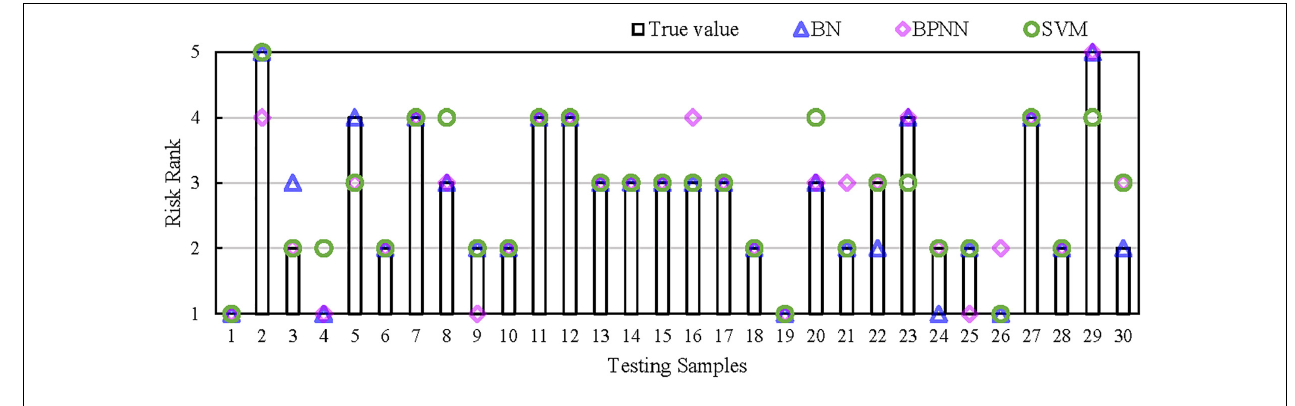
FIGURE 6 | Assessment results of BN, BPNN and SVM.